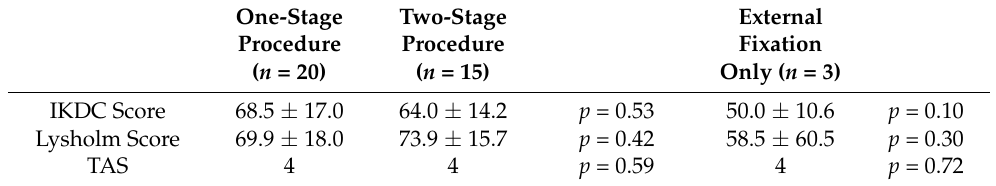
Table 3. Clinical Outcome regarding whether a one-stage procedure, a two-stage procedure or external fixation only was performed. IKDC and Lysholm scores are presented by MD ± SD and the TAS is presented by median. When testing the clinical outcome after external fixation, the results of the one-stage and two-stage approaches were summarized and used for comparison.